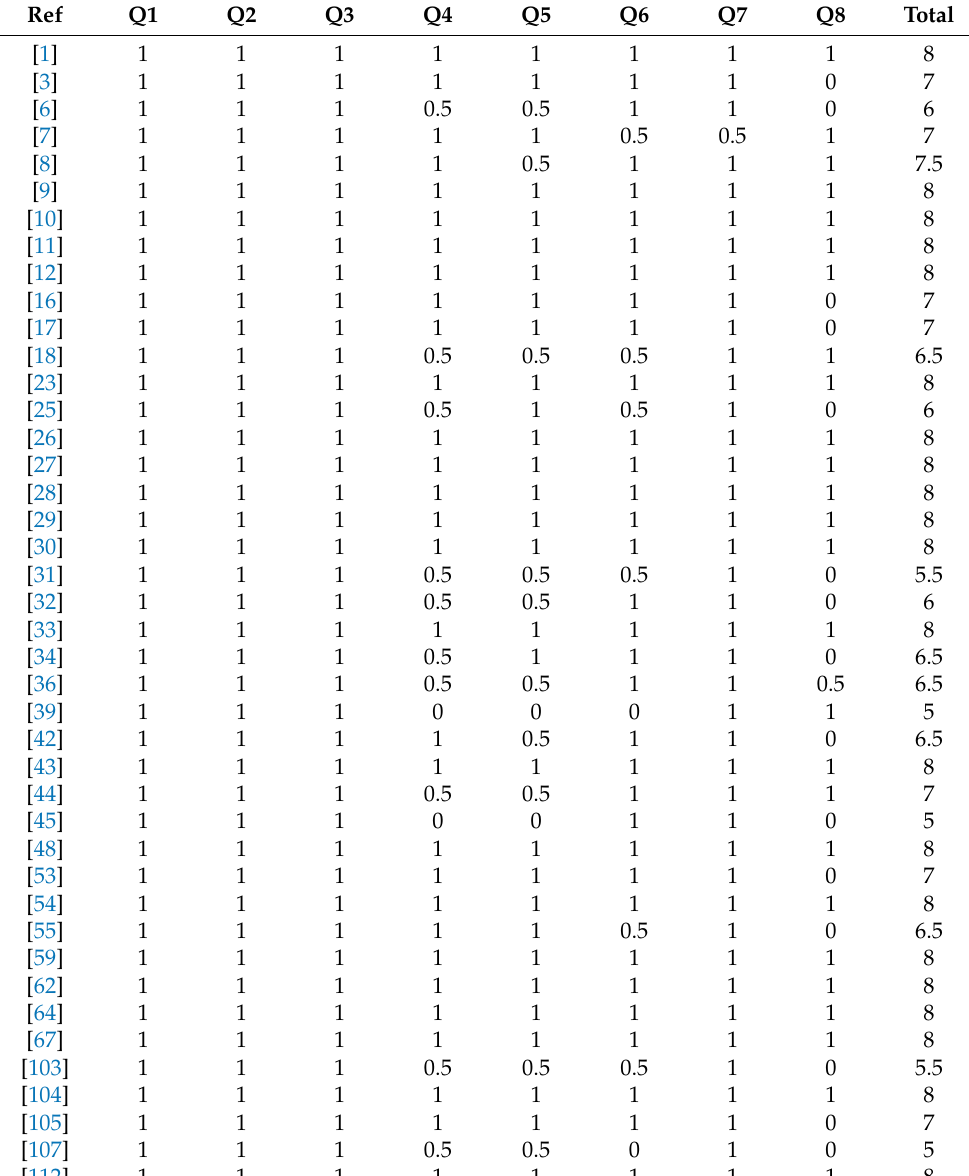
Table A2. Quality assessment